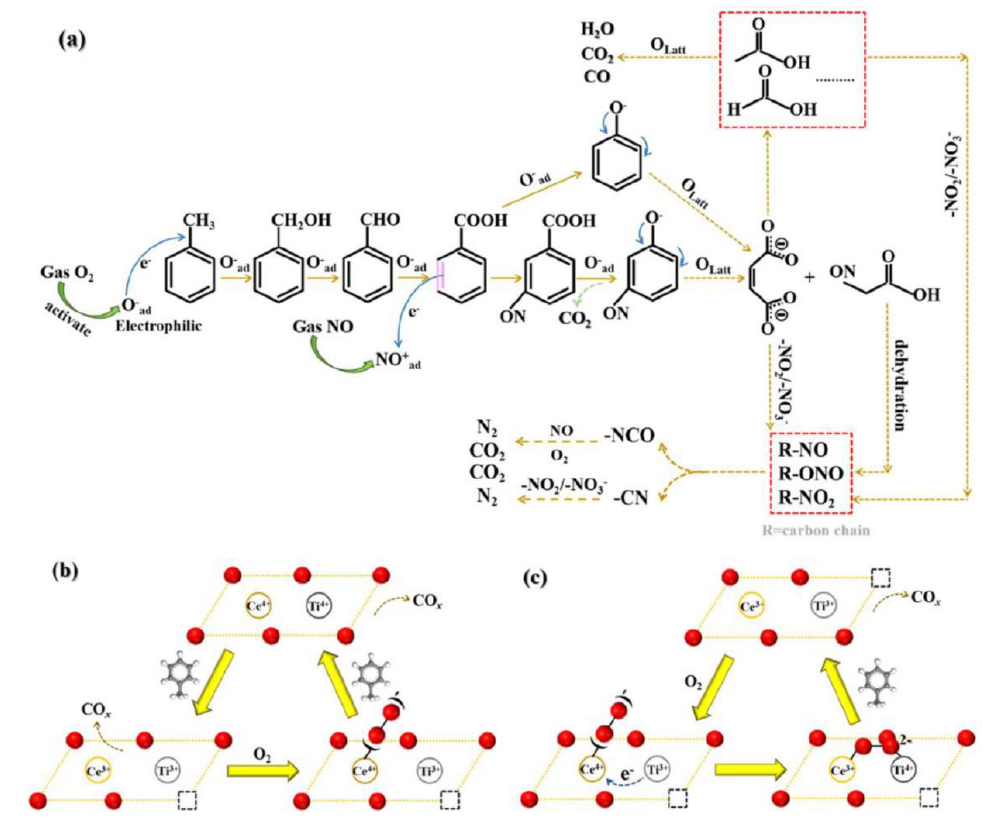
Figure 4. ( a ) Toluene oxidation mechanism in the presence of NO. ( b ) Redox cycle over CeO 2 -TiO 2 TiO 2 surface under low-temperature conditions ( ≤ 200 ◦ C). ( c ) Redox cycle at high temperatures surface under low-temperature conditions (≤200 °C). ( c ) Redox cycle at high temperatures (≥275 °C) [107]. Copyright 2022, American Chemical Society. ( ≥ 275 ◦ C) [107]. Copyright 2022, American Chemical